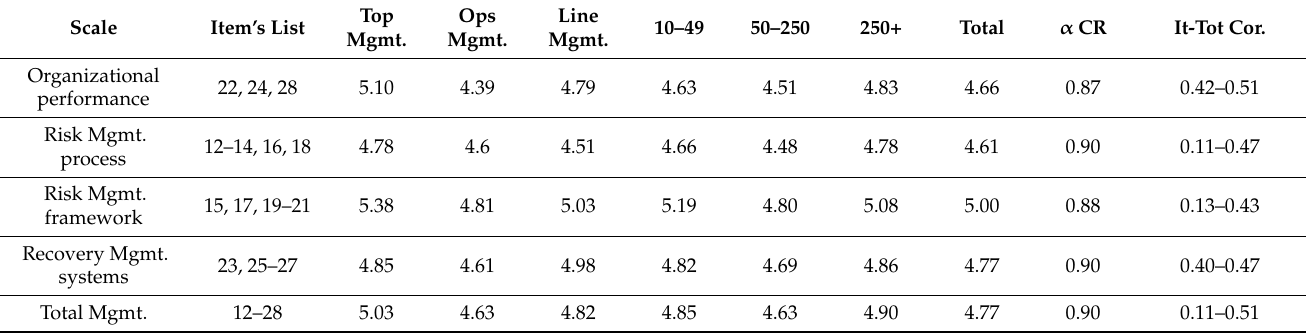
Table 7. Scales of risk management and organizational performance